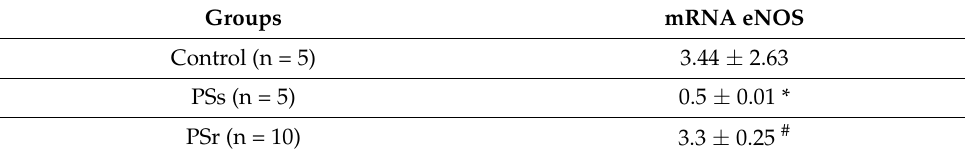
Table 2. Effect of PS on eNOS mRNA expression in control, PSs, and PSs rats. Groups